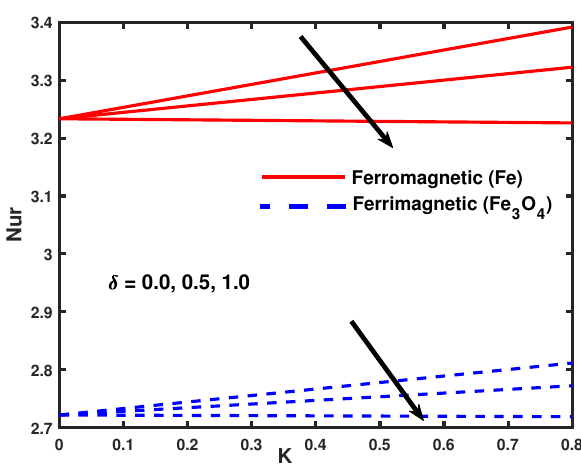
Figure 17. Impact of magnetic nano-particles and boundary parameter ( δ ) on the Nusselt number.